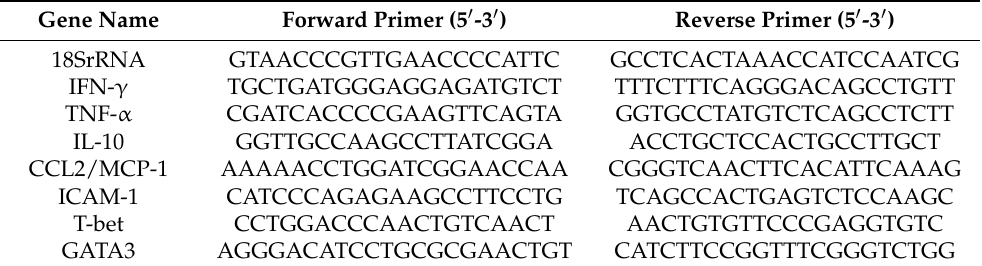
Table 1. Primer sequences (FastStart DNA Master Sybr Green) for analysis of mRNA expression. Gene Name